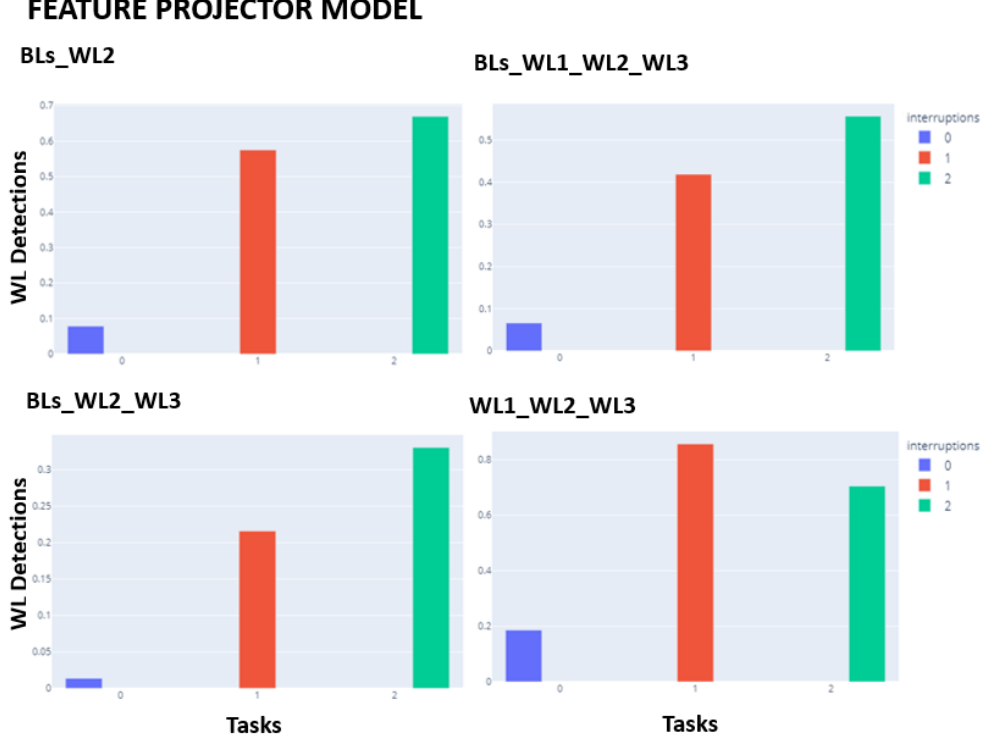
Figure 5. FRAM tasks barplots of WL predictions for the feature projector